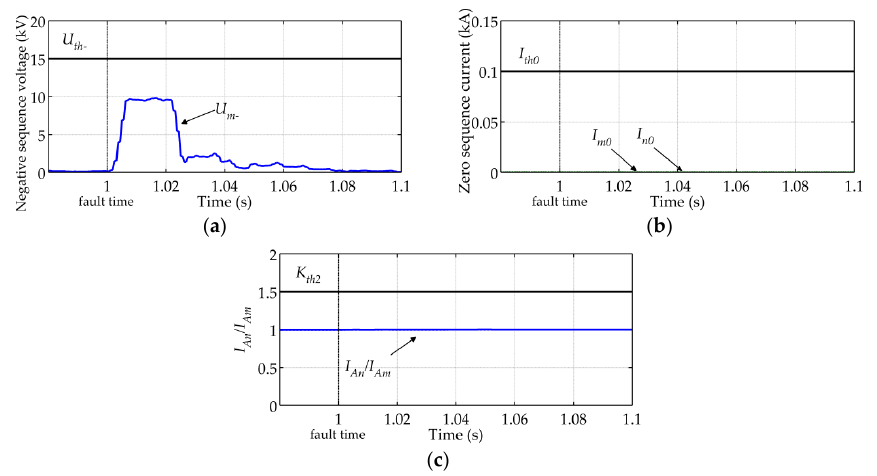
Figure 22. Values detected by relays under an external balanced fault: ( a ) Magnitude of negative-sequence voltage at bus m side of line mn; ( b ) Magnitudes of zero-sequence currents at both sides of line mn; ( c ) The ratio between phase A currents flowing through both sides of line mn.